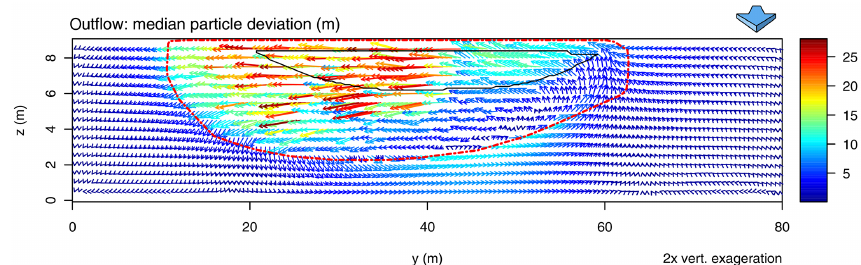
Figure 9. Median particle deviation between the inflow face and the outflow face (computed vertically for every five cells) represented by arrows. The arrow length and colour correspond to the deviation magnitude. The black line represents the shape of the trough fills projected on the outflow face and the dashed, red line represents convex hull of the particles on the outflow face that flowed through the trough fills. The blue arrow indicates the main flow